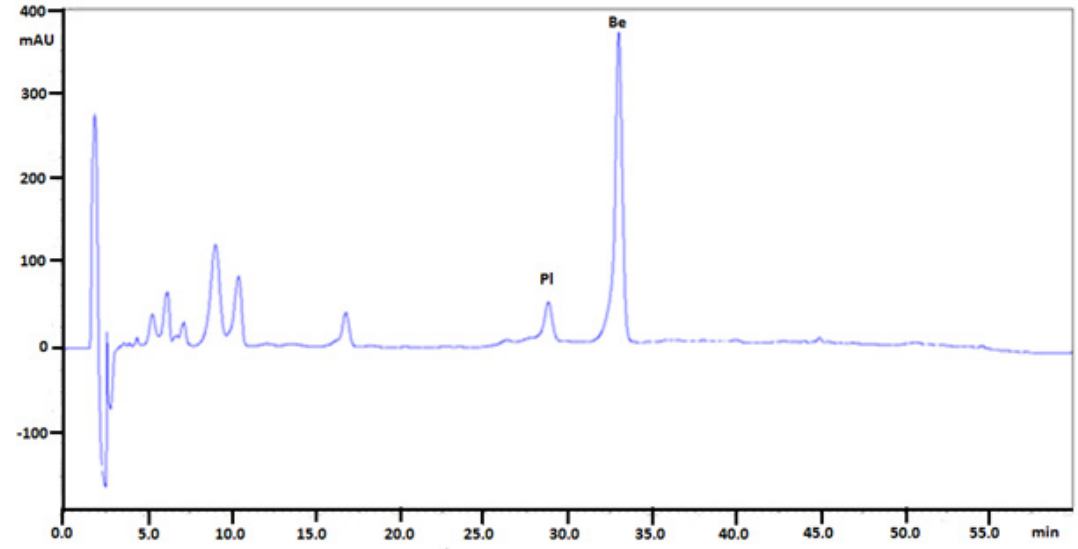
Figure 4. Chromatogram obtained for Mahonia aquifolium roots extract (the extract was diluted 50 times) obtained on Polar RP column with mobile phase MeCN, water and 1-butyl-3-methylimidazolium tetrafluoroborate. Abbreviations: Pl—palmatine, Be—berberine. Plant material was collected during flowering.